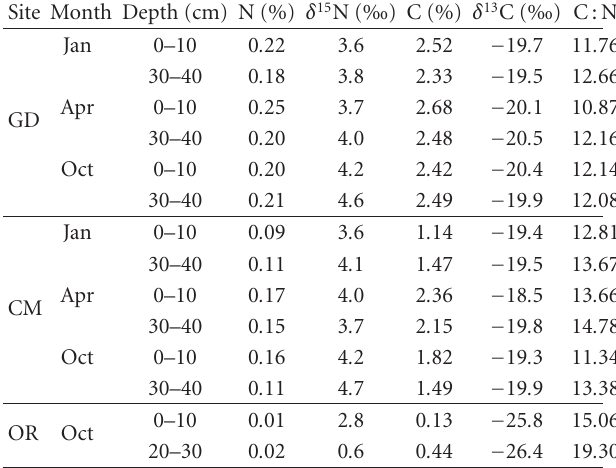
Table 2: Characteristics of sediment organic matter for Grave’s Dock (GD), Chechessee Marsh (CM), and Oyster Rake